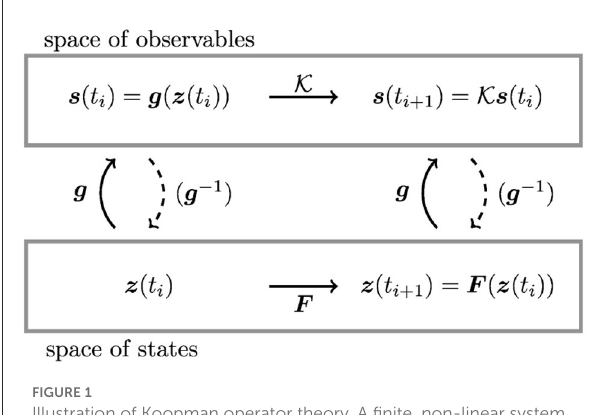
FIGURE1 Illustration of Koopman operator theory. A finite, non-linear system described by states z ∈ R n and a non-linear function F : R n → R n can be transformed into an often infinite-dimensional, linear system described by observables s ∈ R K and Koopman operator K : R K → R K . The measurement functions g : R n → R K and their inverse counterparts g − 1 : R K → R n link between the two